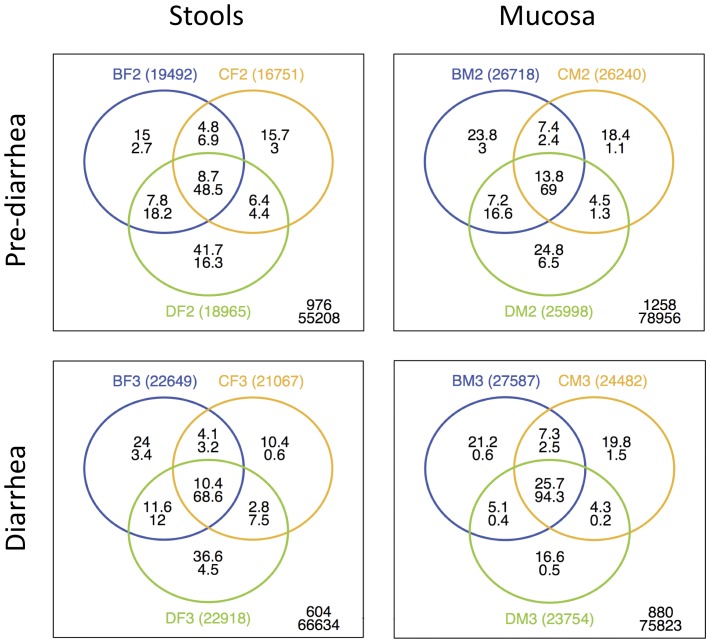
The number of shared phylotypes between individuals increases due to osmotic diarrhea.The number of shared phylotypes (OTU distance = 0.03) between individuals increases during diarrhea in stools (left) but more pronouncedly in mucosa (right) samples (8.7–10.4% vs. 13.8–25.7%). The figure indicates the relative (%) phylotype (upper number) and sequence overlap (lower number) of stool (F) and mucosa (M) samples of individuals B, C and D at time-point 2 (top) and time-point 3 (bottom).